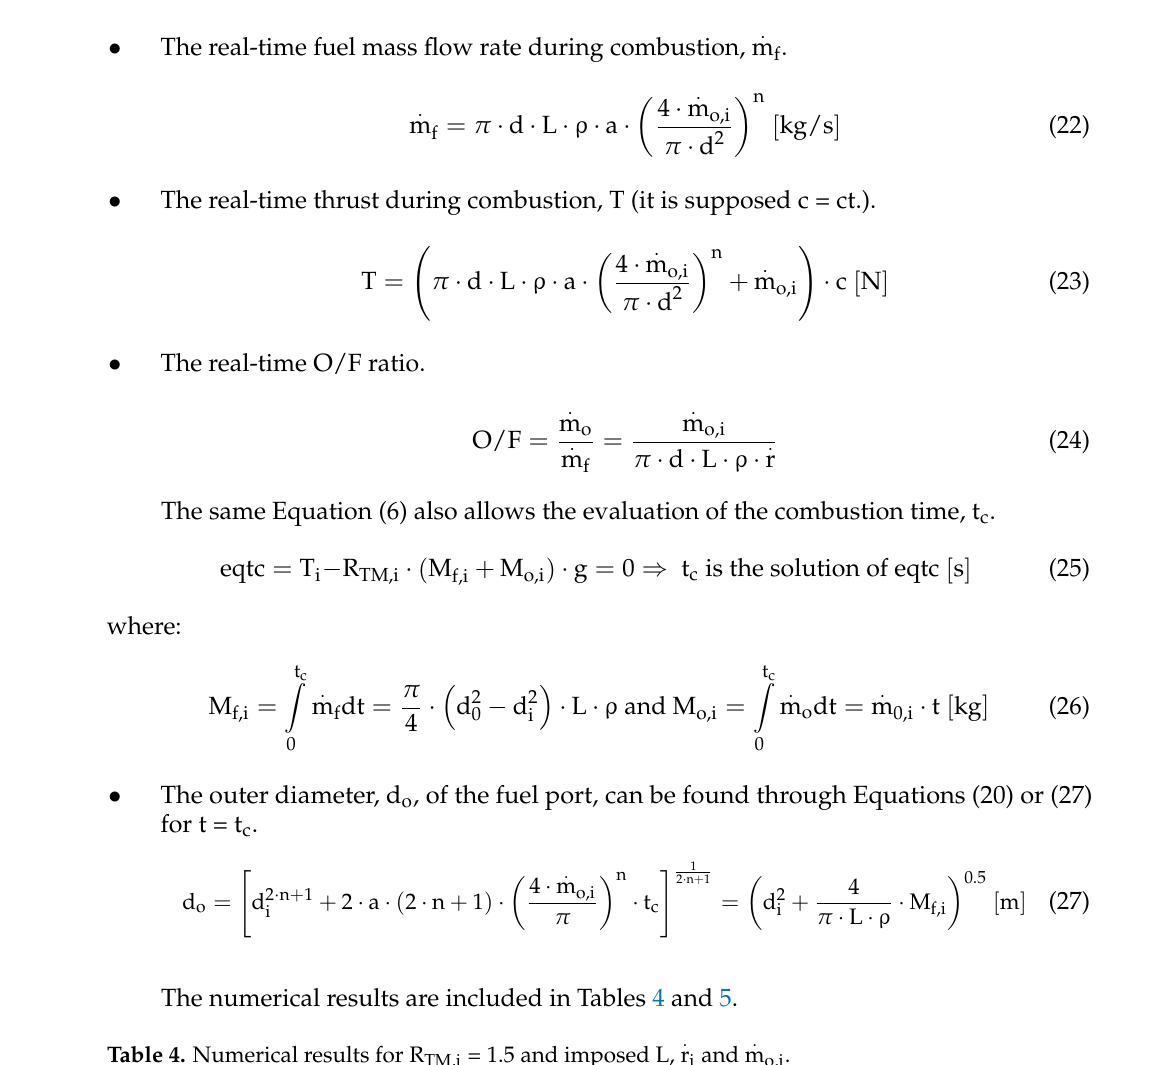
Table 4. Numerical results for R TM,i = 1.5 and imposed L,